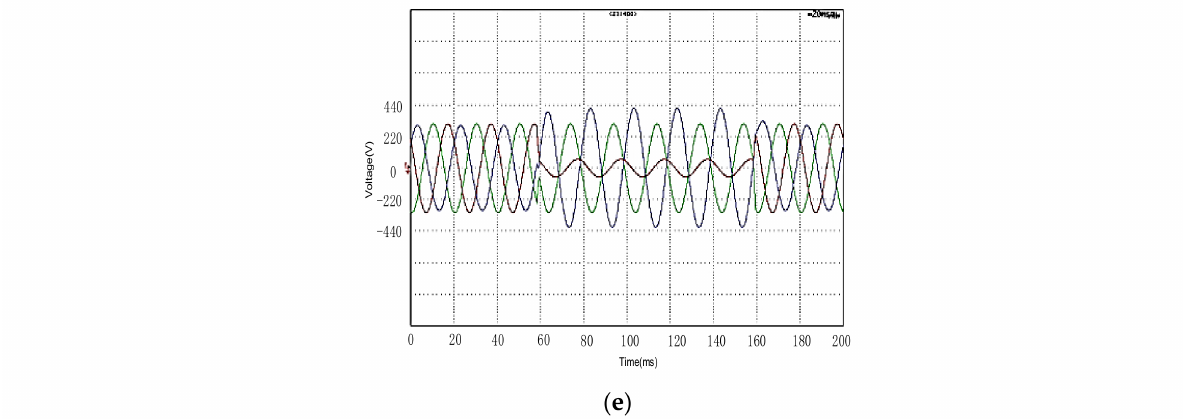
Figure 12. Test waveforms. ( a ) Three-phase sags to 20% (0.2 pu). ( b ) Three-phase swells to 140%. ( c ) Single-phase sags to 20% (0.2 pu). ( d ) Single-phase swells to 140% (1.4 pu). ( e ) Phase A swells to 140% (1.4 pu), phase B sags to 20% (0.2 pu), and phase C phase angle jumping 60 ◦